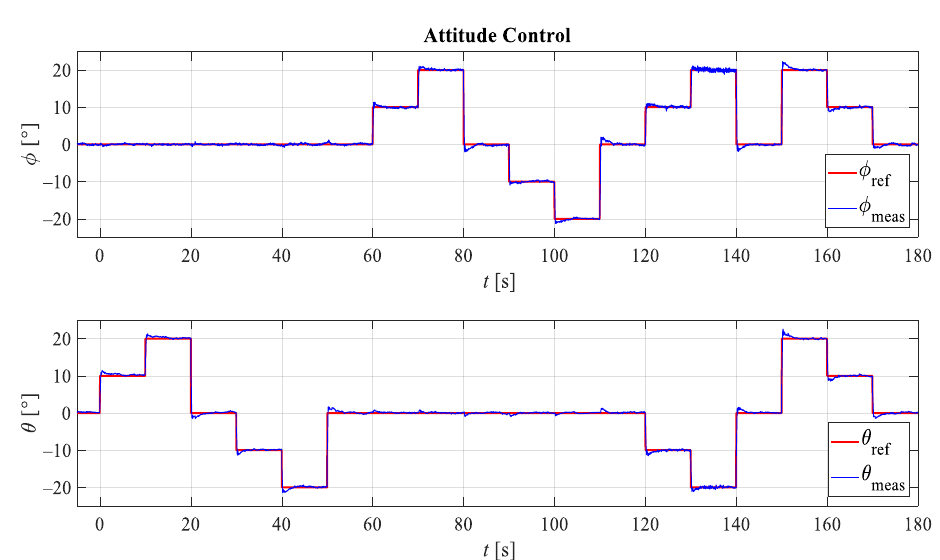
Figure 17. Experimental results of flat quadrotor configuration (FX4) response for attitude control.